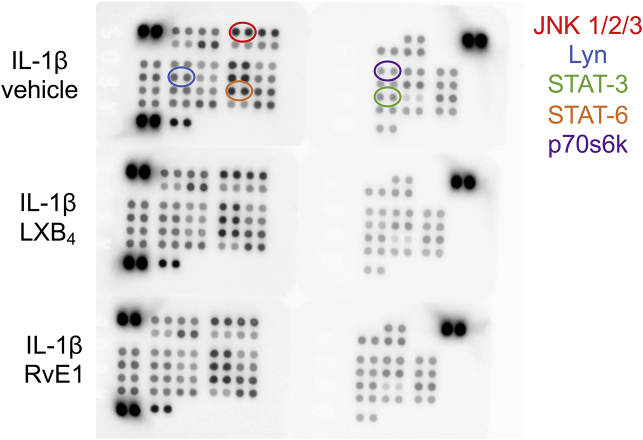
Effects of lipoxin B4 (LXB4) and resolvin E1 (RvE1) on protein kinase expression in diseased tendon stromal cells. The image showing human phosphokinase array (ARY003B; R&D Systems, Minneapolis, MN) was used to detect phosphorylated proteins in lysates of IL-1β–stimulated diseased tendon stromal cells in the presence of 10 nmol/L LXB4, RvE1, or vehicle for 24 hours. Data are shown from an 8-minute exposure. Image is representative of data from incubated cells derived from one donor. Quantitative analysis of data from three donors is shown in Figure 5. Human phosphokinase array coordinates are listed in the R&D Systems product insert Proteome Profiler Array, Human Phospho-Kinase Array Kit. Minneapolis, MN. Colored circles show phosphorylated proteins of interest shown in Figure 5.